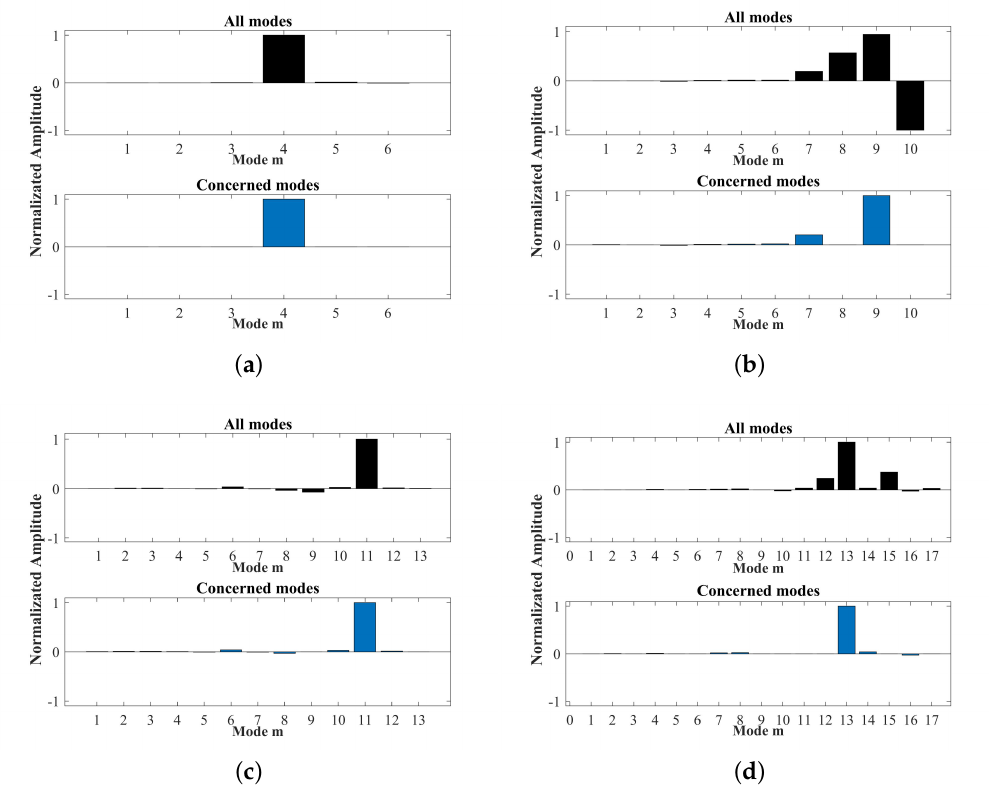
Figure 9. Normalizated amplitudes of modes: ( a ) 25 kHz M4, ( b ) 80 kHz M9, ( c ) 100 kHz M11, ( d ) 155 kHz